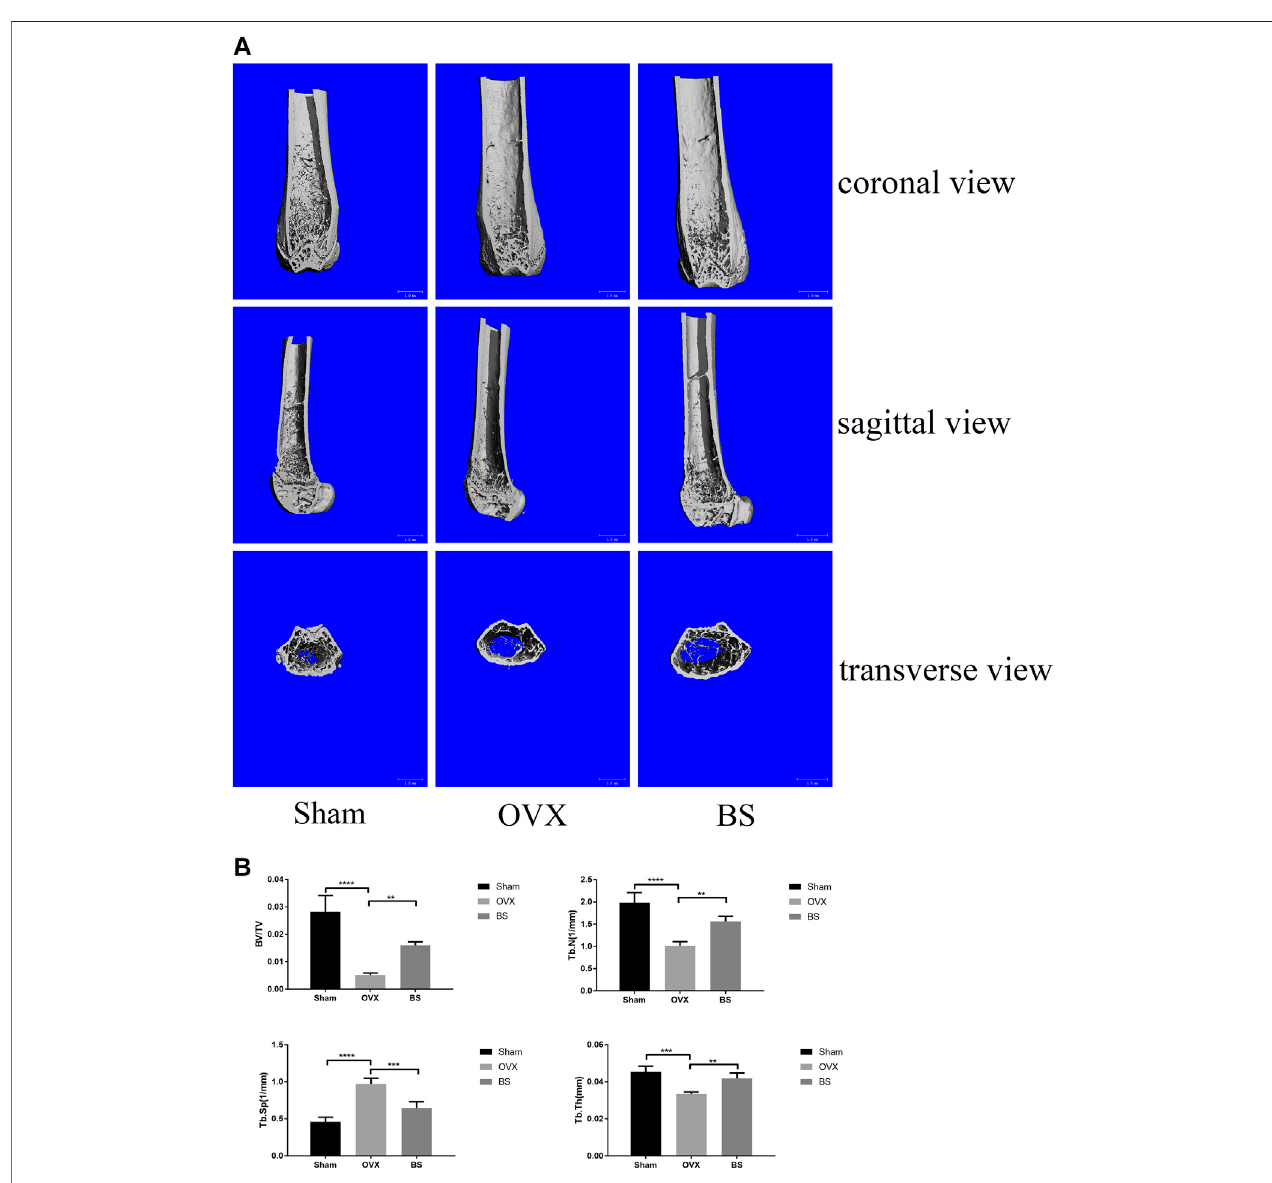
FIGURE 8 | BS-inhibited ovariectomized – induced bone loss. (A) Representative 3D reconstruction micro-CT images of the trabecular bone of distal femoral metaphysis. (B) Quantitative micro-CT assessment of the trabecular structure: trabecular bone volume/tissue volume (BV/TV), trabecular number (Tb.N), trabecular thickness (Tb.Th), and trabecular separation (Tb.Sp). All bar graphs are presented as mean ± SD; n = 10. pp p < 0.01; ppp p < 0.001; **** p < 0.0001.